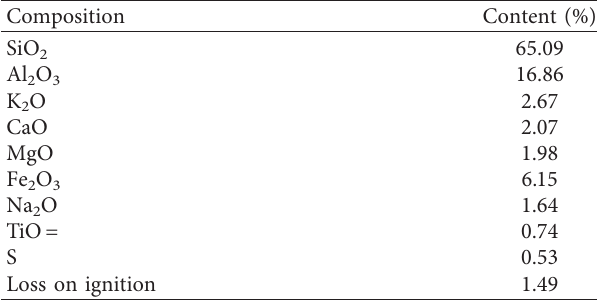
Table 1: Analysis results of main chemical components of coal gangue (%).